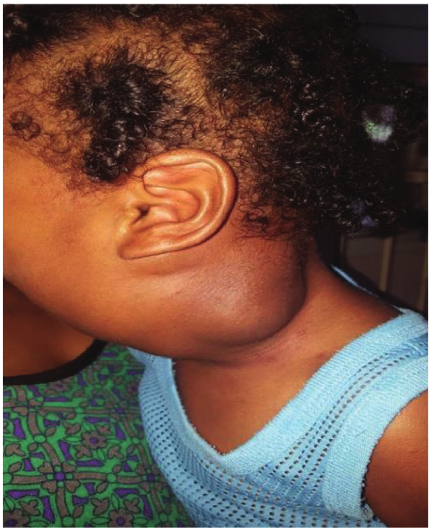
Figure 8: Cystic hygroma 6 months after treatment.